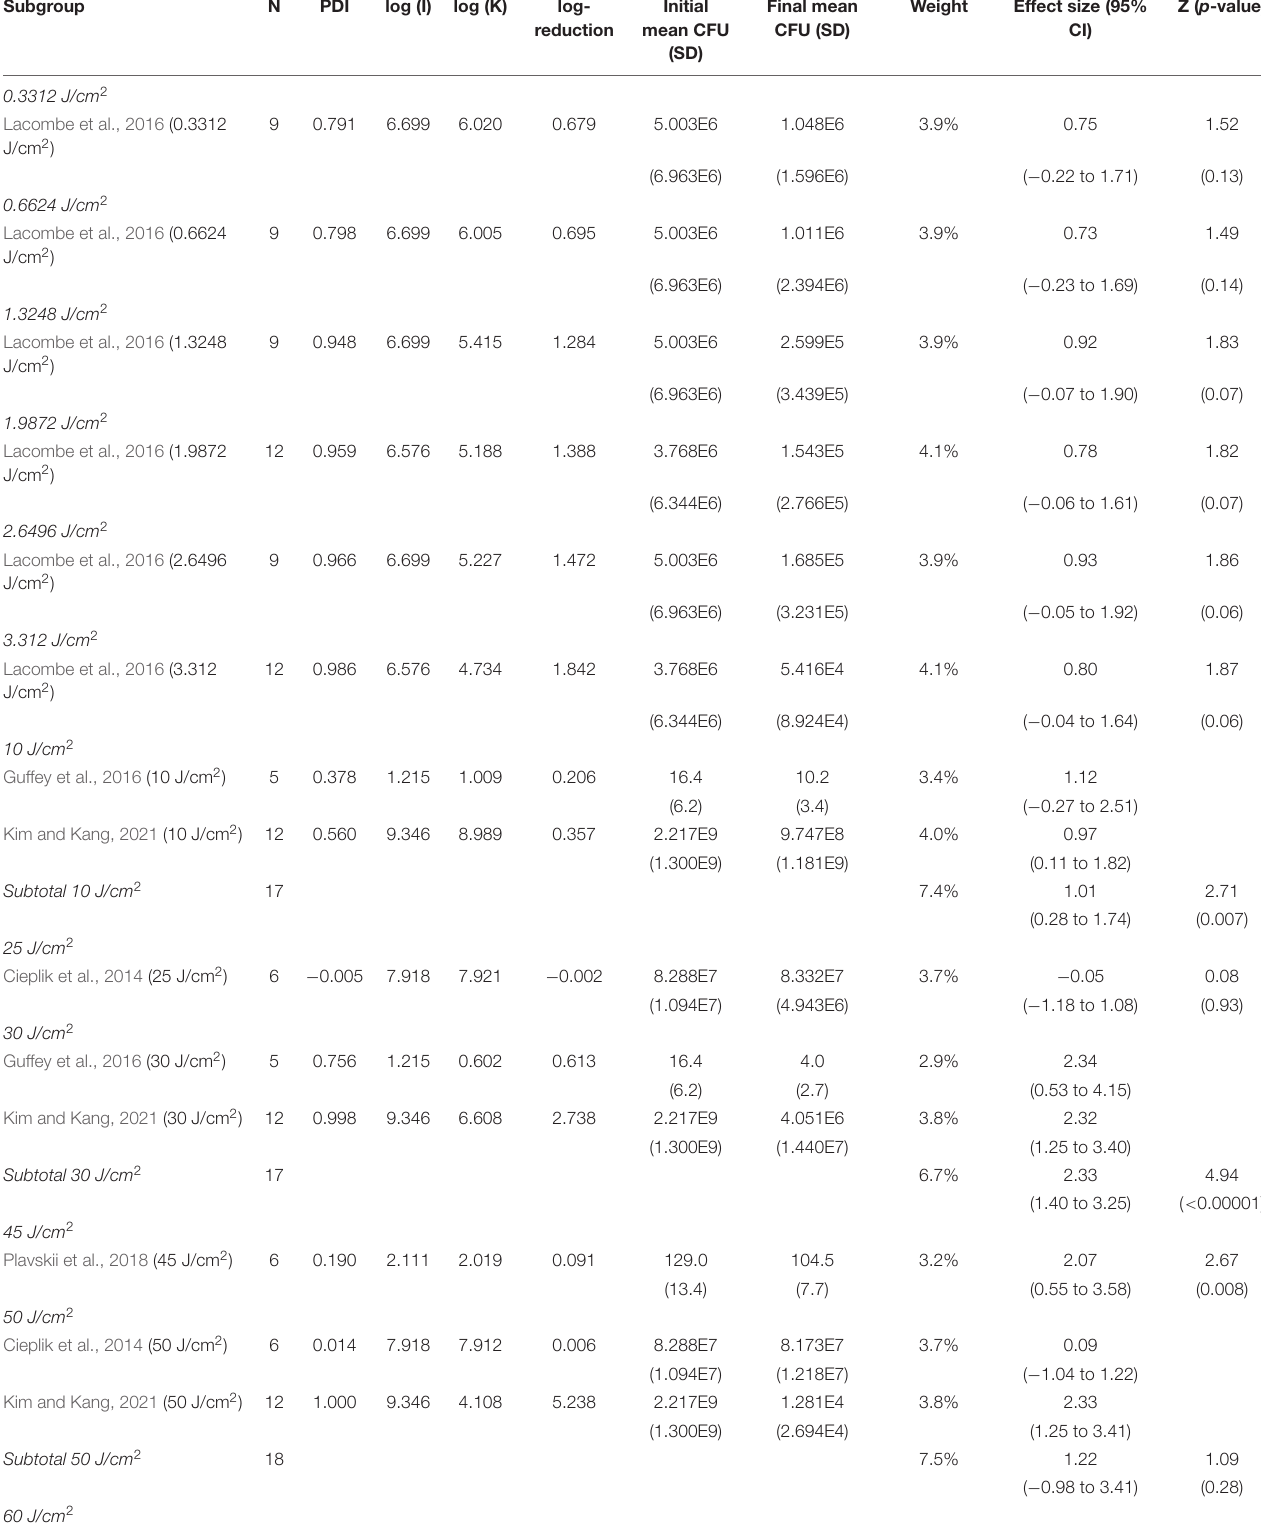
TABLE 5 | CFU E. coli outcomes by exposure doses.